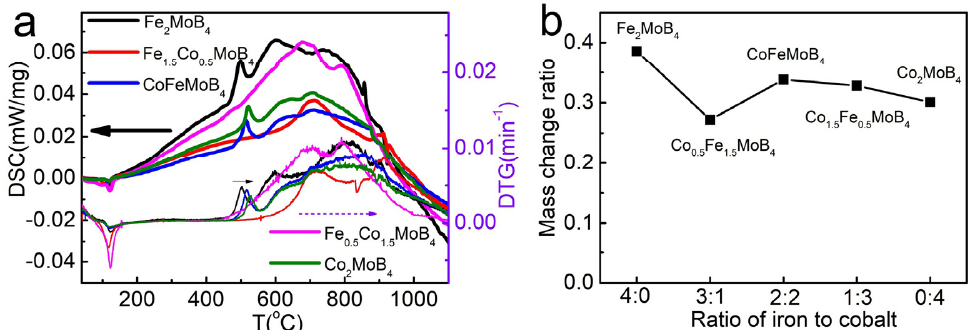
Figure 4. ( a ) Mass normalized DSC and DTG curves of different samples; ( b ) the mass change per- centage of different samples after TG-DTA